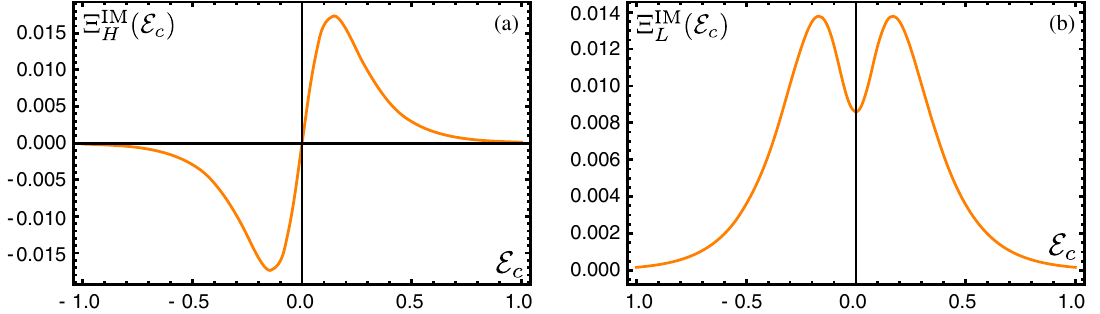
ð E Þ and (b) Ξ IM ð E Þ . Both functions vanish in the limits of the fully filled and empty lattice ( E c c H L